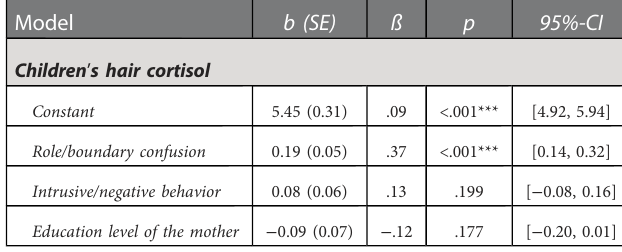
TABLE 3 Results of robust multiple linear regression with AMBIANCE subscales role/boundary confusion and intrusive/negative behavior as predictors for child ’ s hair cortisol level and maternal education.